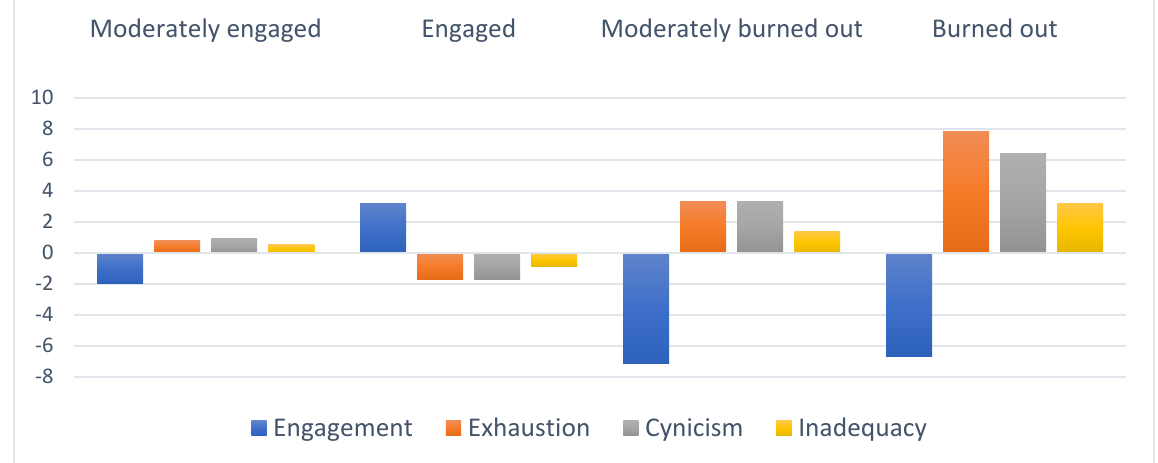
Figure 1. Standardized means on the clustering variables by profiles.